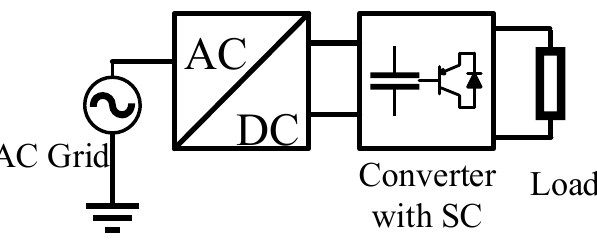
Figure 19. Schematic diagram of the plug-in converter with supercapacitor.